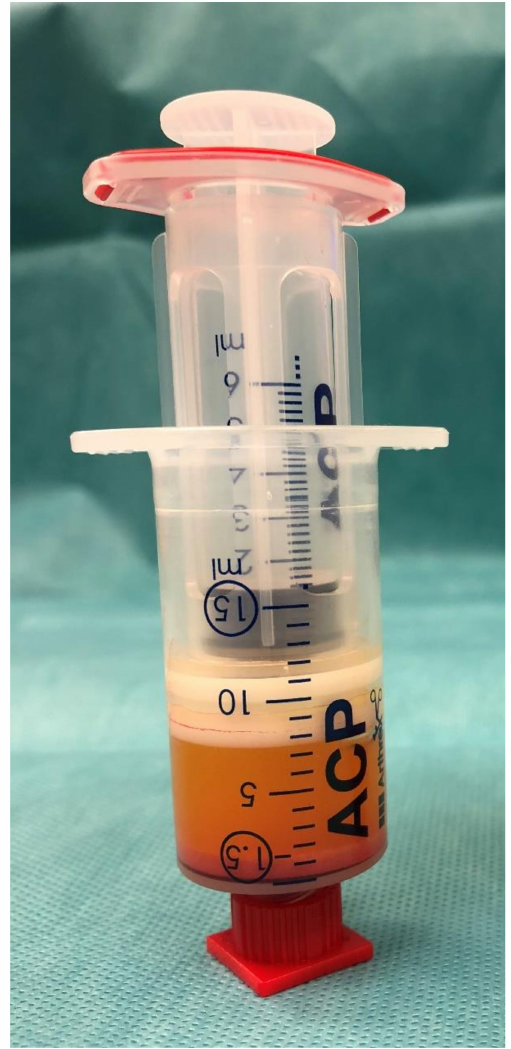
Figure 2. Emulsified, homogenized fat graft with oily phase and cell pellet at the